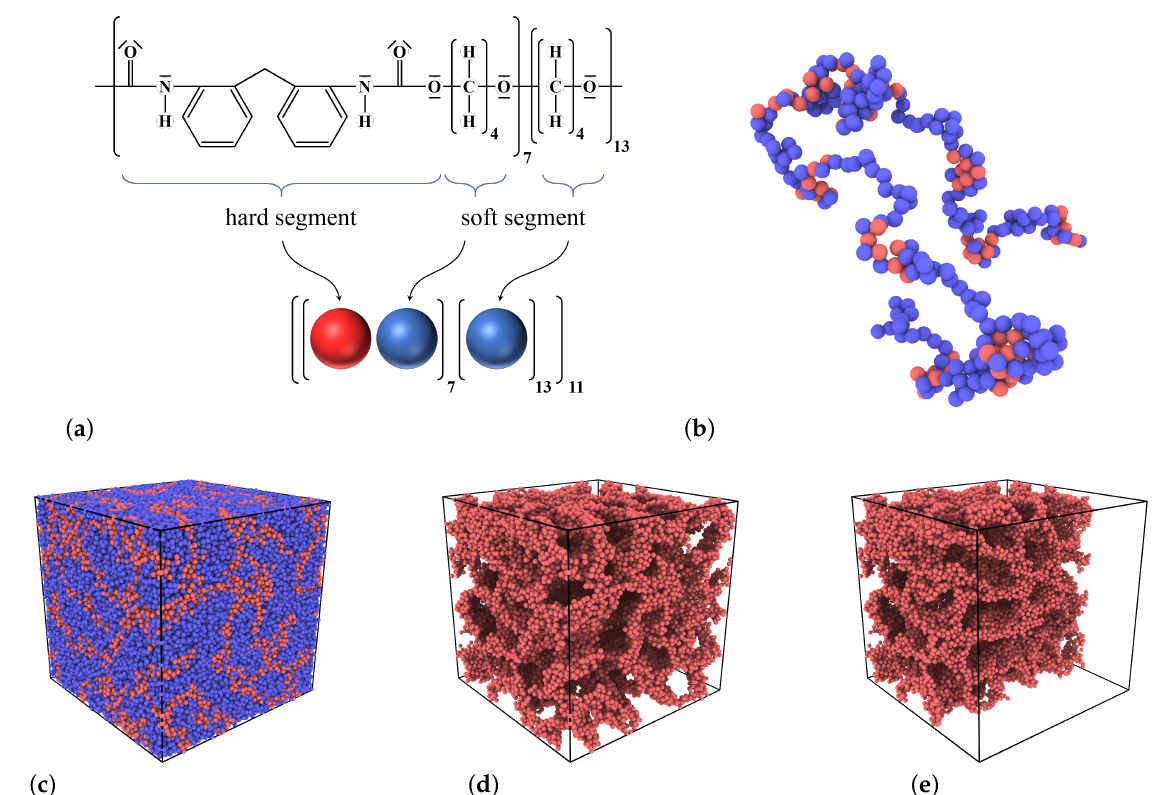
Figure 1. ( a ) Molecular structure of ESTANE ® , consisting of strongly and weakly interacting (‘hard’ and ‘soft’) segments as indicated (Courtesy of Axel Marquardt [58]). In our simplified model, each hard segment is represented as a type A (red) particle and each soft segment by a type B (blue) sphere. The arrangement and number of A and B particles follows the sequence of hard and soft segments in the experimental sample. As a result, each bead-spring chain consists of 77 ‘hard’ and 220 ‘soft’ segments, making a total of N p = 297 monomers per chain. ( b ) A snapshot of a single chain from our simulations. ( c ) Snapshot of the simulation box containing 400 chains which shows a heterogeneous distribution of hard (red) and soft (blue) segments. ( d ) The same data as in ( c ) but hiding the soft segments. ( e ) The same data as in ( d ) but keeping only half of the simulation box. Panels ( d , e ) serve to highlight the phase separation between hard and soft segments on the nano-scale. The snapshots are taken from a pure sample at T =